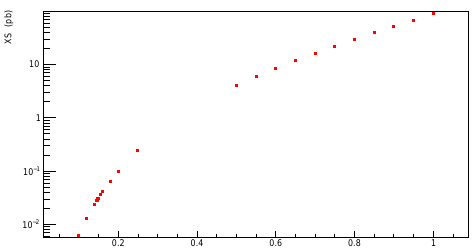
Figure 3: A cross-section scan of the semi-visible jets signal having a mediator mass of 1500 GeV, and a dark-matter candidate mass of 10 GeV with respect to λ